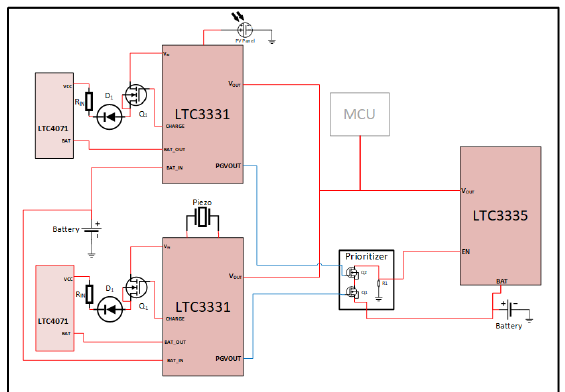
Figure 7. High level schematic of our proposed energy management module. It contains the two LTC3331 with the LTC4071 as the external charger, the LTC3335 and the prioritizer we